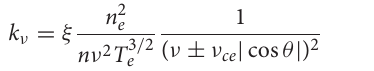
FIGURE 1 | Left : Model of the microwave brightness temperature spectrum of free-free emission (adapted from Gary and Hurford, 1994). © AAS. Reproduced with permission. Right : Brightness temperature spectrum of part of an active region, with crosses and boxes representing left-hand and right-hand circular polarization, respectively. The observations were obtained with the OVSA at 16 frequencies in the range 1.4–8 GHz (adapted from Gary and Hurford, 1987 ). © AAS. Reproduced with